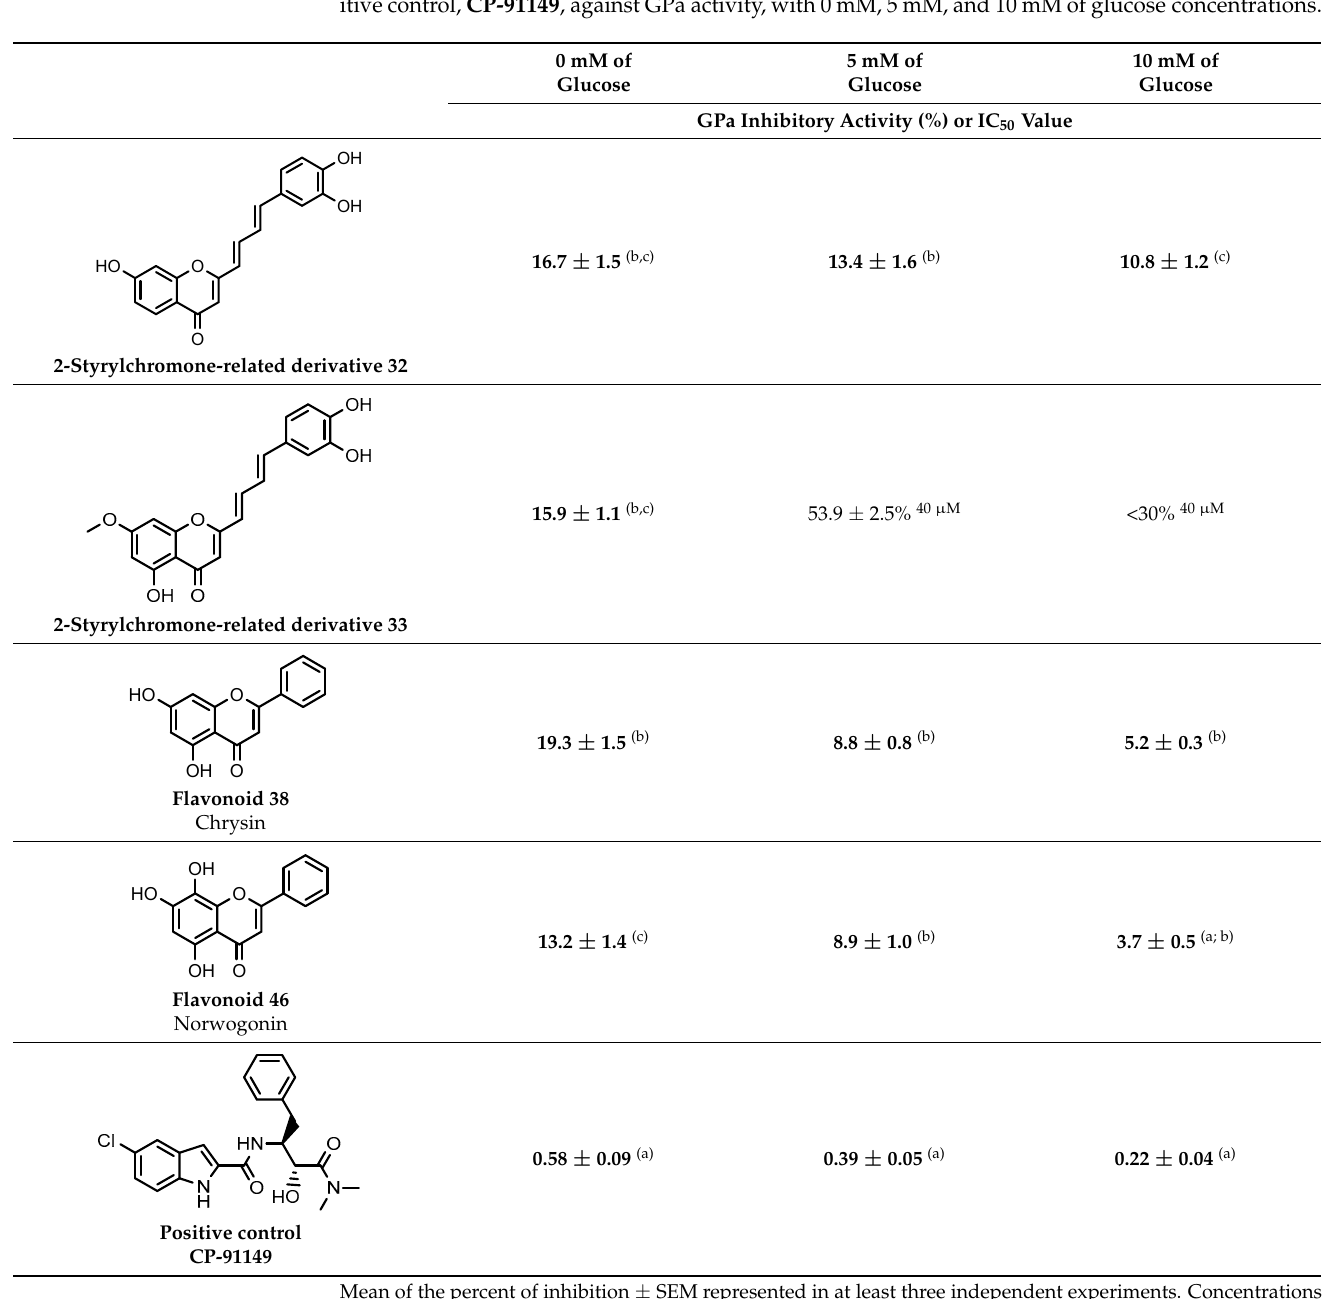
Figure 3. X-ray structure of GPa protein (from 6Y55) in blue, and its co-crystallised ligand in yellow. The ligand is bound at the inhibitor binding site (or caffeine binding site). The molecular docking protocol for GPa docking calculations was validated through self- and cross-docking experiments. We observed that nine ligands with AutoDock and twelve ligands with LeDock were well reproduced (RMSD < 2.5 Å) in their original PDB structures (Figure S1). The PDBs that showed a good self-docking performance was submitted to cross-docking, where we considered only the ligands with structures that were more representative of the compounds in this work (1L5R, 3EBO, 1C8K, 1Z62, 3EBP, 6Y55, 6Y5C, 6Y5O). We noticed that AutoDock performed significantly better than LeDock and, overall, 6Y55 paired with AutoDock reached the best overall performing